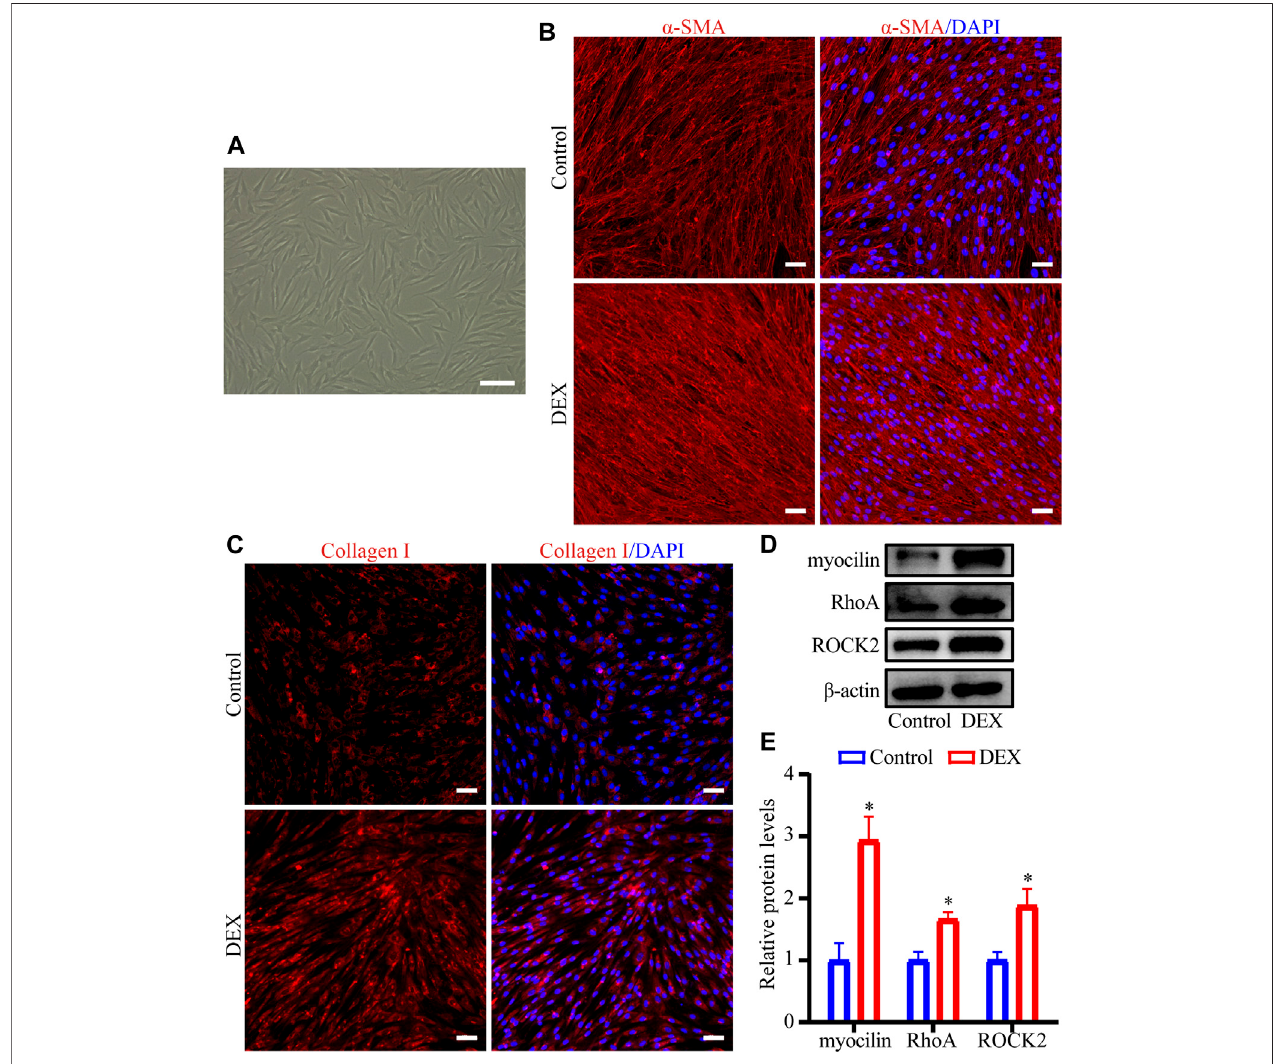
FIGURE 6 | DEX upregulated Collagen I and α -SMA levels and regulated RhoA/ROCK in HTM cells (A) Phase-contrast microscopic image of HTM cells (B,C) The fl uorescent images of (B) α -SMA and (C) Collagen I proteins were observed by immuno fl uorescence staining. Scale bar, 100 μ m (D) The bands of myocilin, RhoA, and ROCK2 proteins and (E) quanti fi cation analyses of myocilin, RhoA, and ROCK2 expression levels. * p < 0.05.